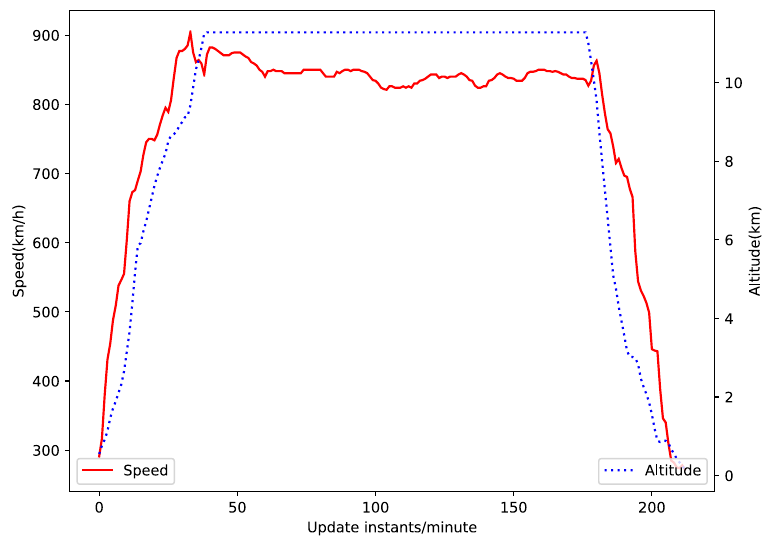
Figure 5. The speed and altitude of a certain flight during its operation.